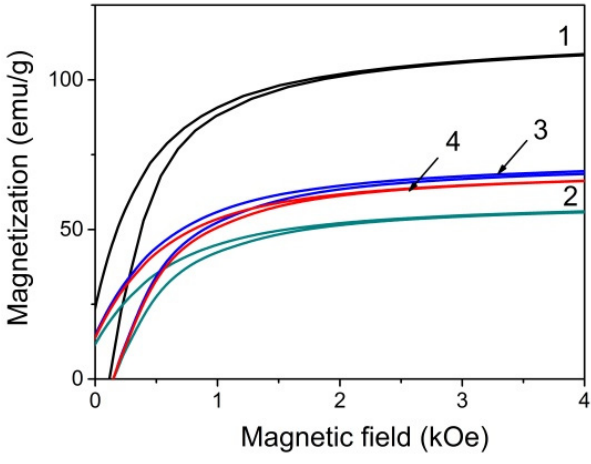
Figure 5. Room temperature magnetization curves for all NPs: Fe 3 O 4 (1), Fe 3 O 4 @SiO 2 (2), Fe 3 O 4 @SiO 2 -NH 2 (3), and Fe 3 O 4 @SiO 2 -NH 2 -EY